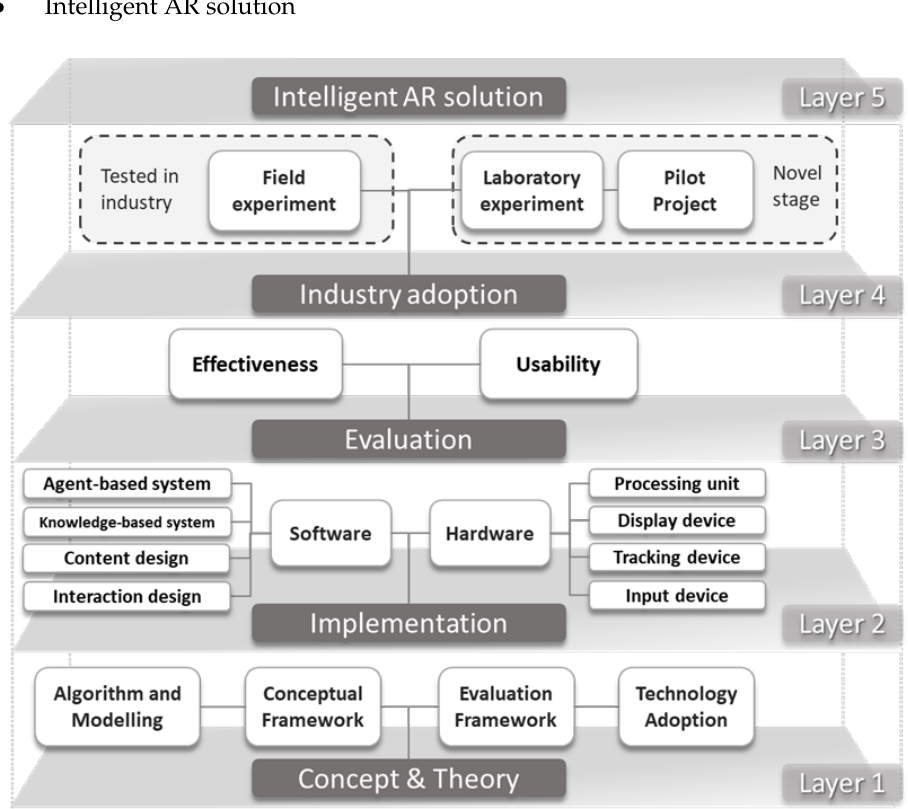
Figure 6. The architecture layer framework of an AR system, adopted from [226].